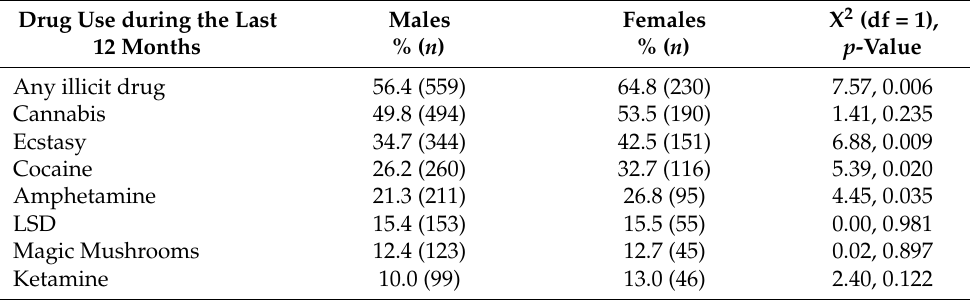
Table 4. Use of illicit drugs during the last 12 months across